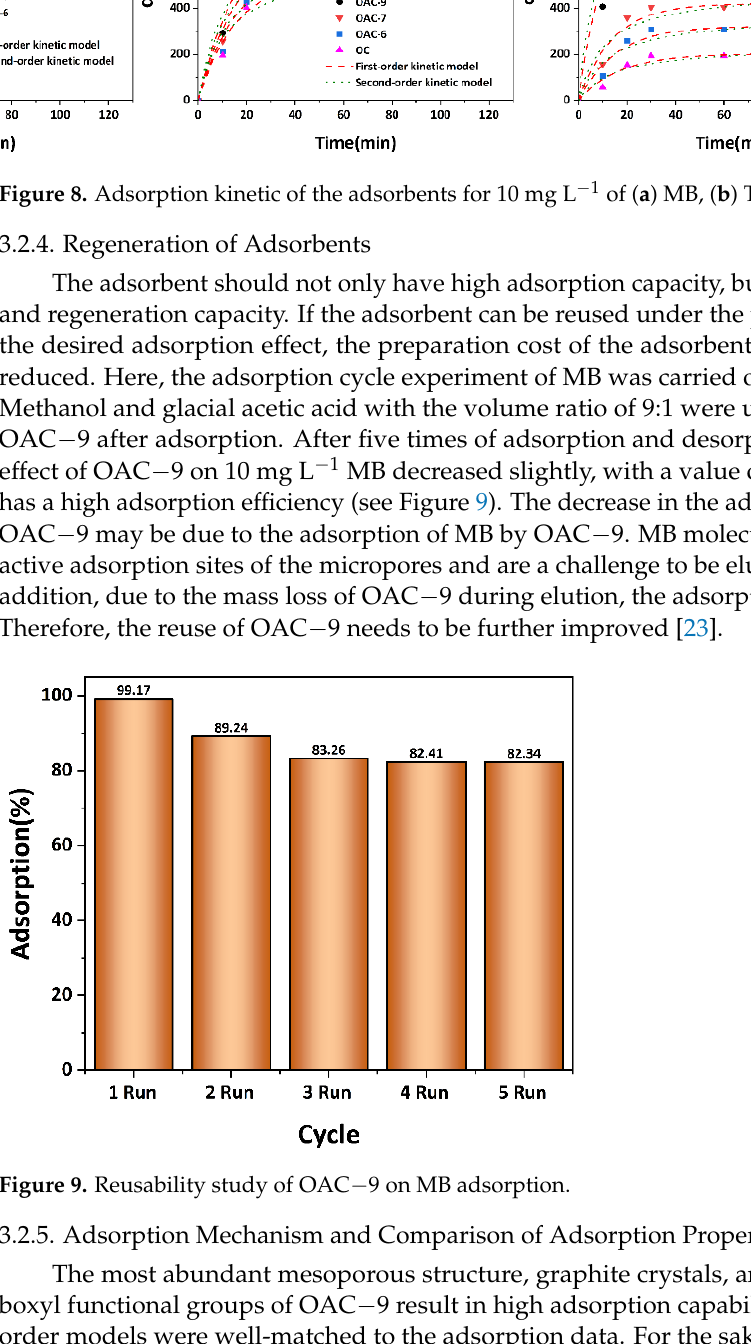
Table 3. Kinetic parameters of the pseudo-first-order models and pseudo-second-order models for MB, TC, and NaFL adsorption to the carbonaceous materials.